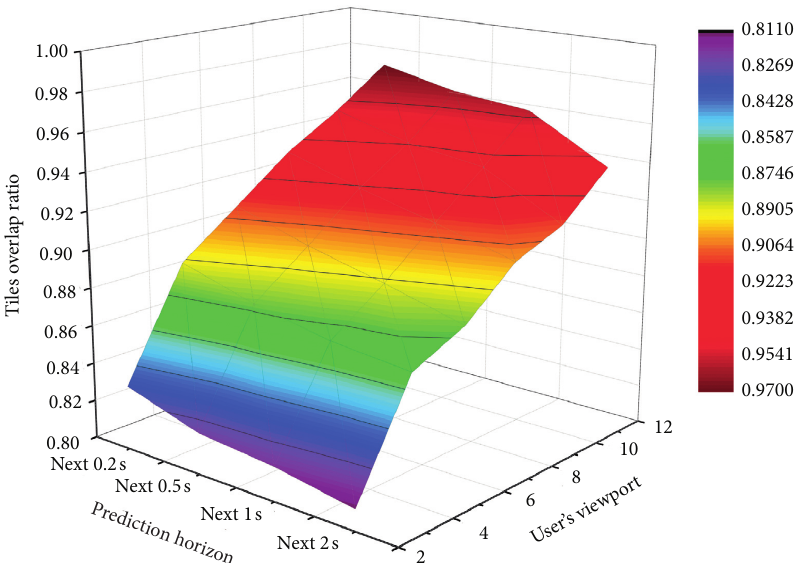
Figure 9: Tile overlapping ratio under different time conditions and different numbers of feedback user viewports.